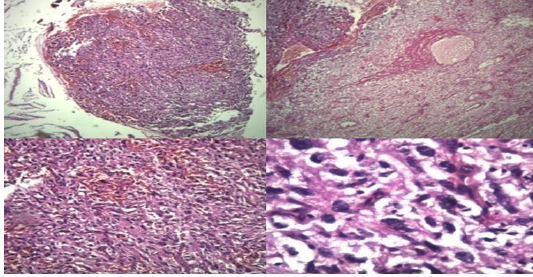
Figure 2. Microscopic feature consisting of psedustratified ciliated columnar epithelium with a mucinous gland diagnosed as typical Malignant Fibrous